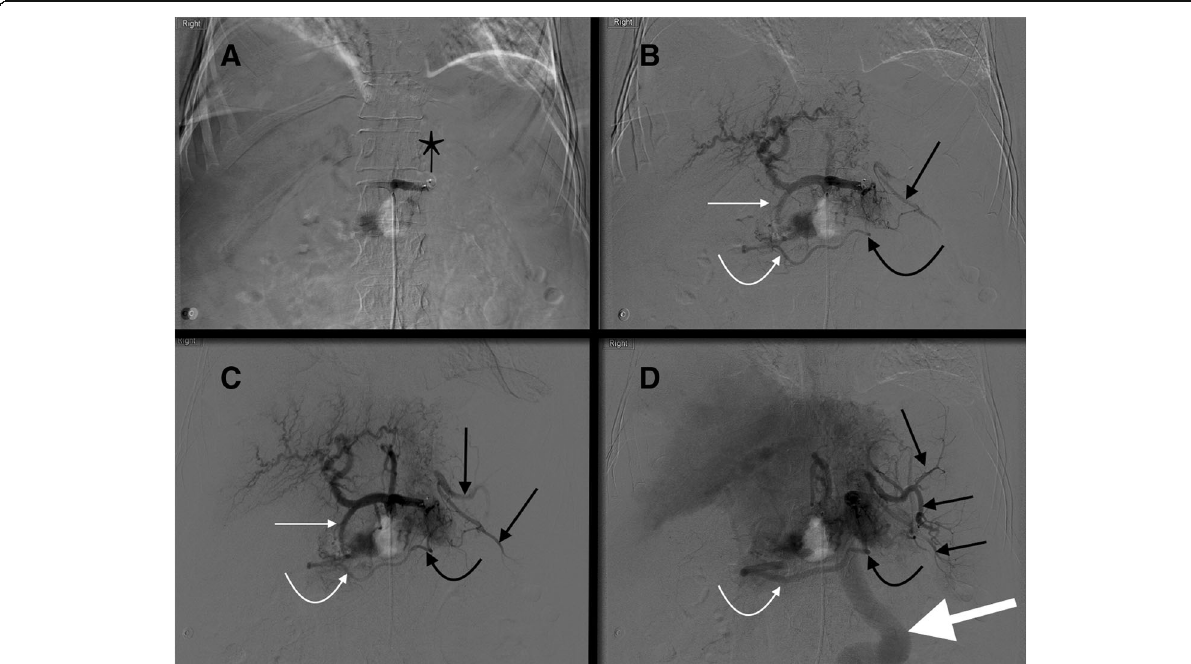
Fig. 9 56 year old female, history of alcoholism, fall from standing height. Celiac artery angiogram after proximal splenic artery embolization with an AMPLATZERTM Plug (star a ). This shows collateral perfusion to the spleen and distal splenic artery (straight black arrows b - d ) via GDA (thin straight white arrow b , c ) → right gastroepiploic (curved white arrow b - d ) → left gastroepiploic pathway (curved black arrow b - d ). Note that the parenchymal opacification of the spleen is markedly delayed compared to the liver, an expected finding after PSAE ( d ). Corkscrew intrahepatic arteries and the recannalized periumbilical vein with hepatopedal flow (thick white arrow b , c ) are consistent with the patient ’ s known history of